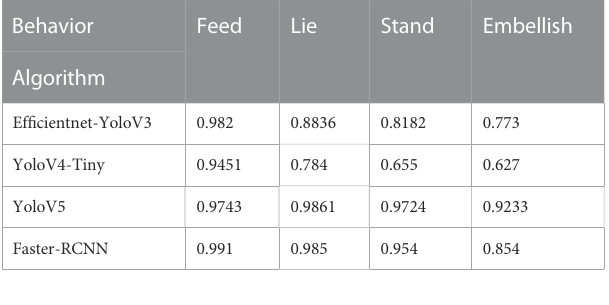
TABLE 1 Comparison of Map values of different algorithms.